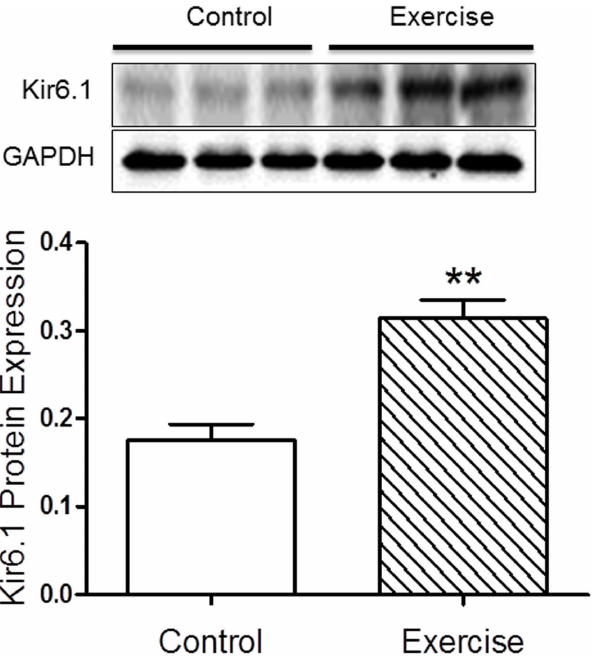
Figure 3. The effect of endurance exercise on Kir6.1 protein expression. Western immunoblotting analyses of VSMC sarc-K ATP channel subunit Kir6.1 were performed on the hearts of the control and exercised mice with GAPDH as the reference. As shown, protein expression levels of Kir6.1 were significantly increased following 8 weeks of endurance exercise (N 5 5/group, **p ,